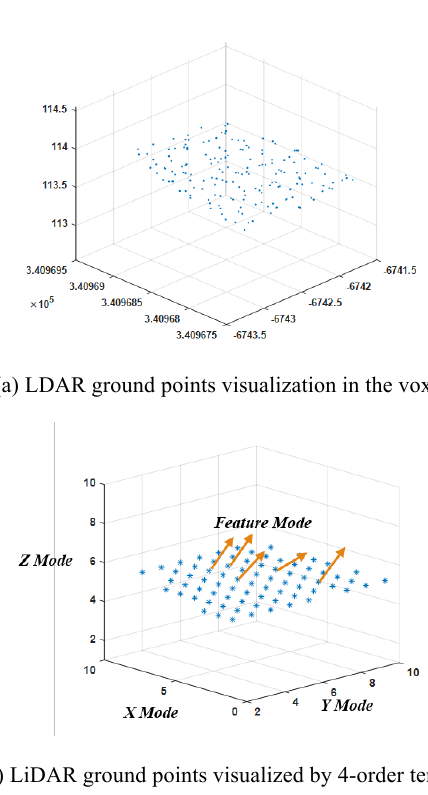
Figure 1. Point distribution in voxel and